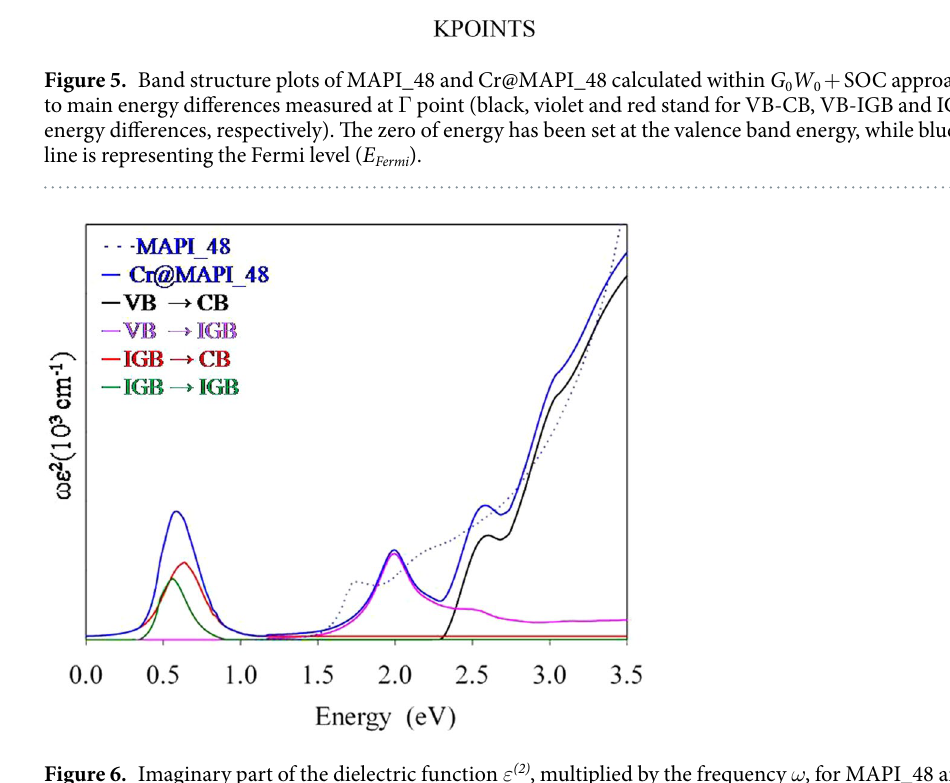
Moreover, three occupied bands also due to Cr 3d -orbitals appear overlapping the VB, with energy somewhat higher than the last occupied bands due to I atoms. As discussed above, Cr atom is placed in an octahedral con- figuration coordinated to six I atoms, with an average I-Cr bond length equal to 2.85 Ǻ. The density of states analysis shows that in the valence band maximum, no significant overlap between Cr 3d and I 5p- orbitals exists, which indicates less covalent bonding between Cr and I in CrI 6 octahedra (Fig. 3). According to crystal field the- ory, in a high spin configuration as is surely the case here the interaction between the transition metal (Cr) and I in a octahedral symmetry would cause a split of the Cr 3 d -orbitals into a low-energy t 2g triplet (due to d xy , d xz and